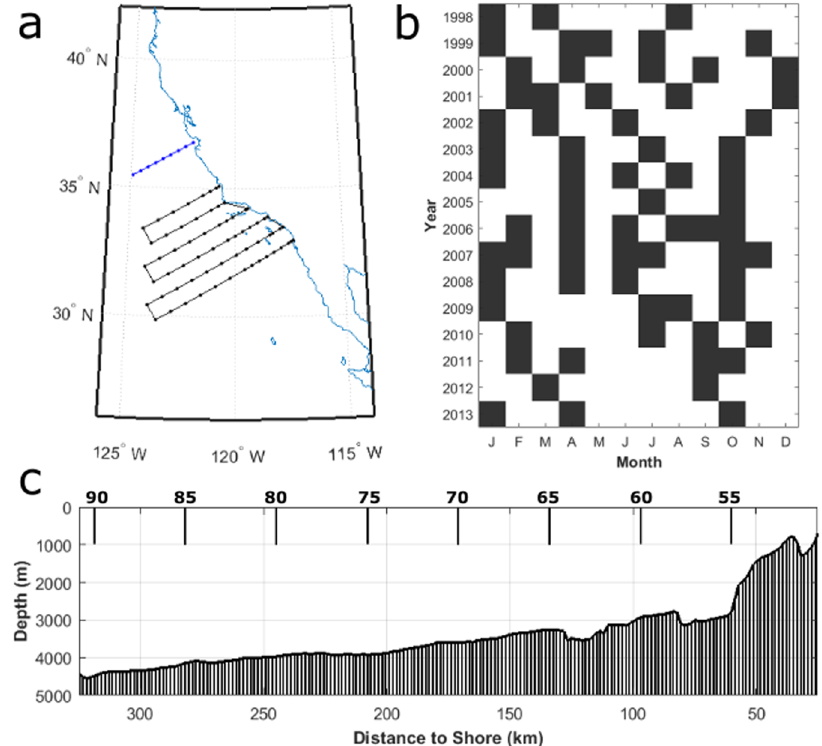
Figure 1. ( a ) Map of the location of CalCOFI Line 67, stations 50 to 90 (blue), and the standard CalCOFI sampling lines (black), ( b ) months of the year with Line 67 cruise data for dissolved oxygen on σ θ = 26.7 kg m − 3 and ( c ) bathymetry and location of Line 67 stations